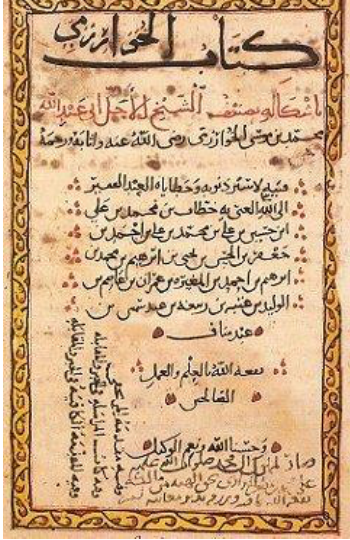
Figure 7. A page from al- Khwarizmi’s “Algebra” [22].